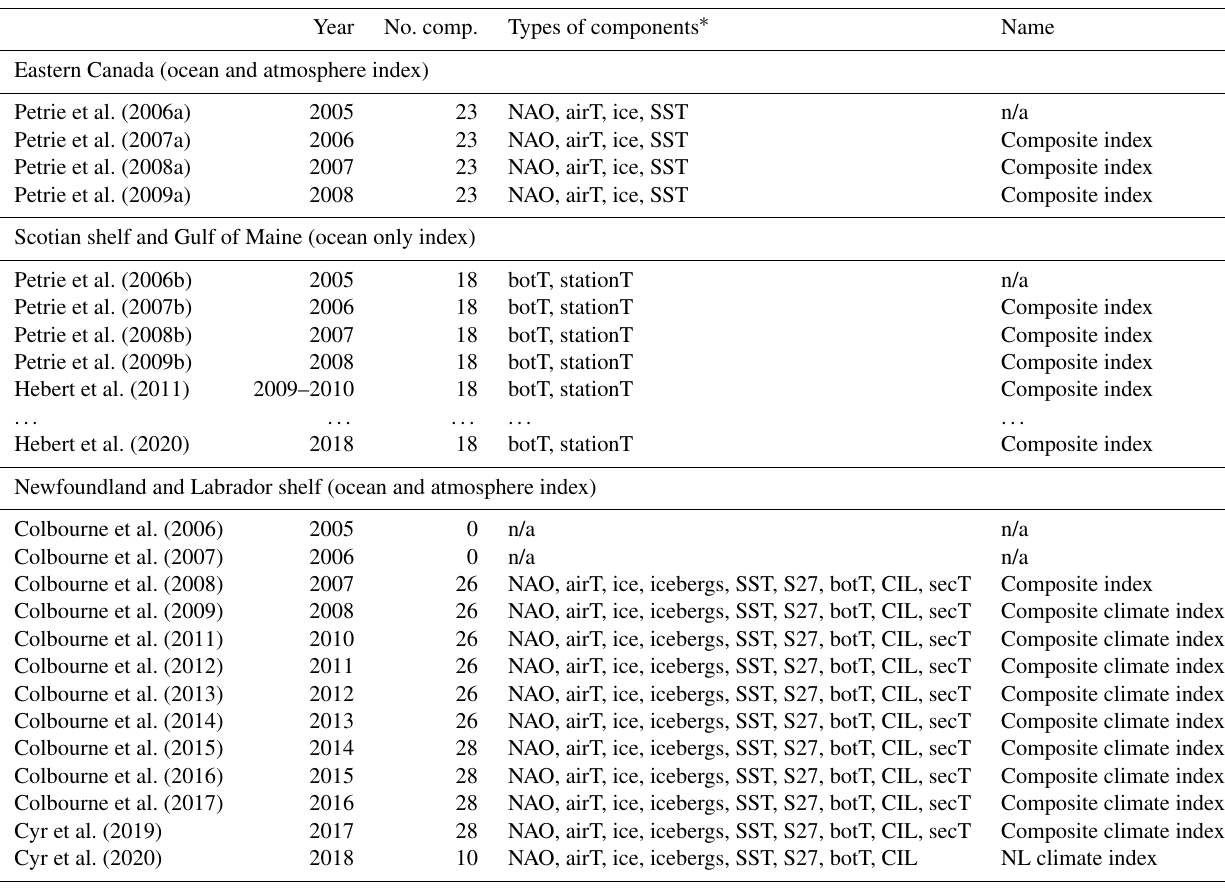
Table 1. Review of AZMP reports that made use of composite or climate indices. The Table is separated into three sections: (1) meteoro- logical, sea ice and SST conditions off eastern Canada; (2) physical oceanographic conditions (review year 2005-2008) and meteorological and sea ice conditions (after 2009) on the Scotian shelf and Gulf of Maine; and (3) physical oceanographic conditions (including sea ice and atmosphere) on the Newfoundland and Labrador shelf. Note that the entries between Hebert et al. (2011) and Hebert et al. (2020) have not been included because their ocean composite index did not change. The different columns are, respectively, the year in review, the number of components in the composite index, the time series used and the name given to this index in the document. Year No.